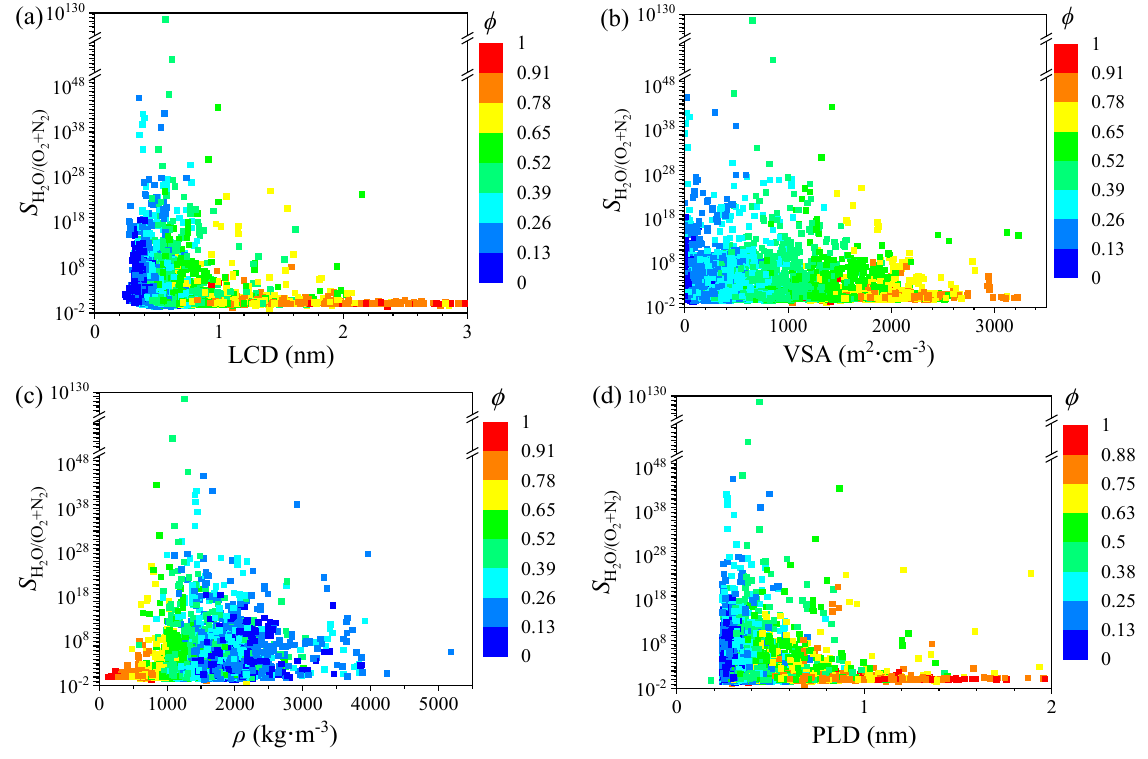
Figure 1. The relationship of selectivity S 0[H2O/(N2+O2)] versus ( a ) LCD, ( b ) VSA, ( c ) ρ , and ( d ) PLD. The color code represents void fraction ϕ .